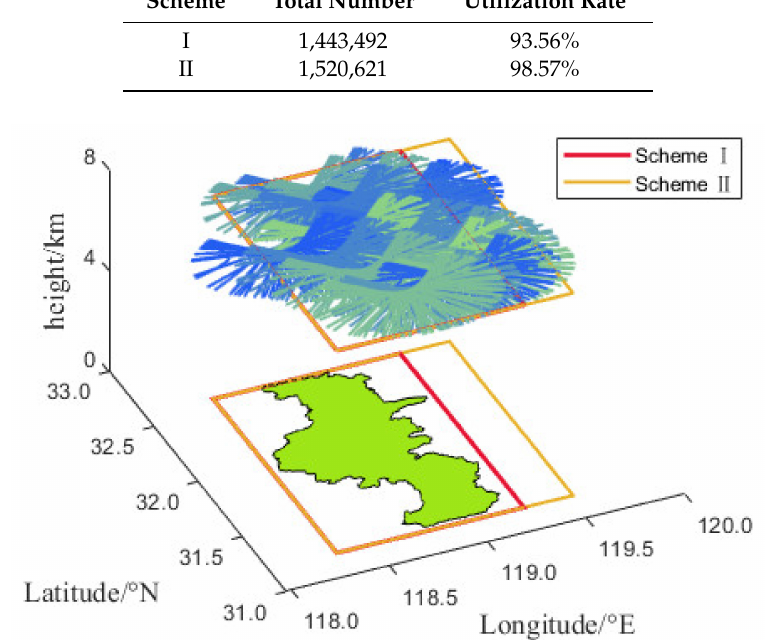
Figure 6. Intersection of the ray and 8-km-high tropopause. In scheme I, a general tomographic horizontal boundary covering only the Nanjing area is used, while in scheme II, the optimal horizontal boundary including the most signals is